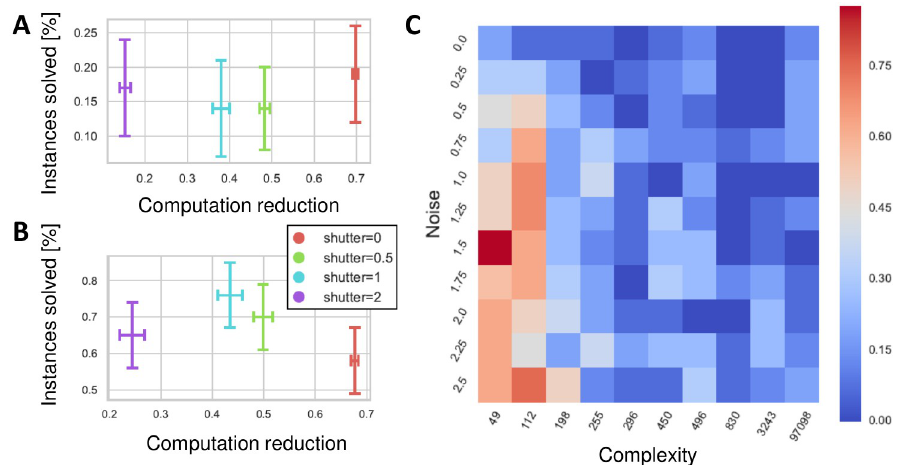
Fig 6. For most of possible search parameters, search with a narrow path shutter is the dominant search strategy. Computation reduction is computed as 1 (cid:0) computation A) Example of a board configuration where a narrow shutter max ð computation Þ is the dominant search strategy since it shows similar probabilities for finding the winning move at substantially lower number of computations. Simulation parameters were: complexity [830], noise level [0.5], branching [5], limit number of moves [30]. B) Example of a board configuration with a trade-off between computation amount and the probability to find a winning move. For the given simulation parameters, an increase from shutter size 0 to shutter size 1 incurs a significantly higher probability to find a winning move but the number of computations increases as well. Simulation parameters were: complexity [49], noise level [0.5], branching [5], limit number of moves [30]. C) The phase space of board complexity vs. noise levels (aggregated over branching factor and search size limitations, see Methods). Each square shows the proportion of configurations in which there was a trade-off between using narrow vs. wider shutter size values: dark blue indicates configurations where the narrow shutter dominates the Pareto front (no trade-off), dark red indicates a trade-off between narrow and wider shutter values (trade-off between computation resources and accuracy). All error bars are 95% confidence